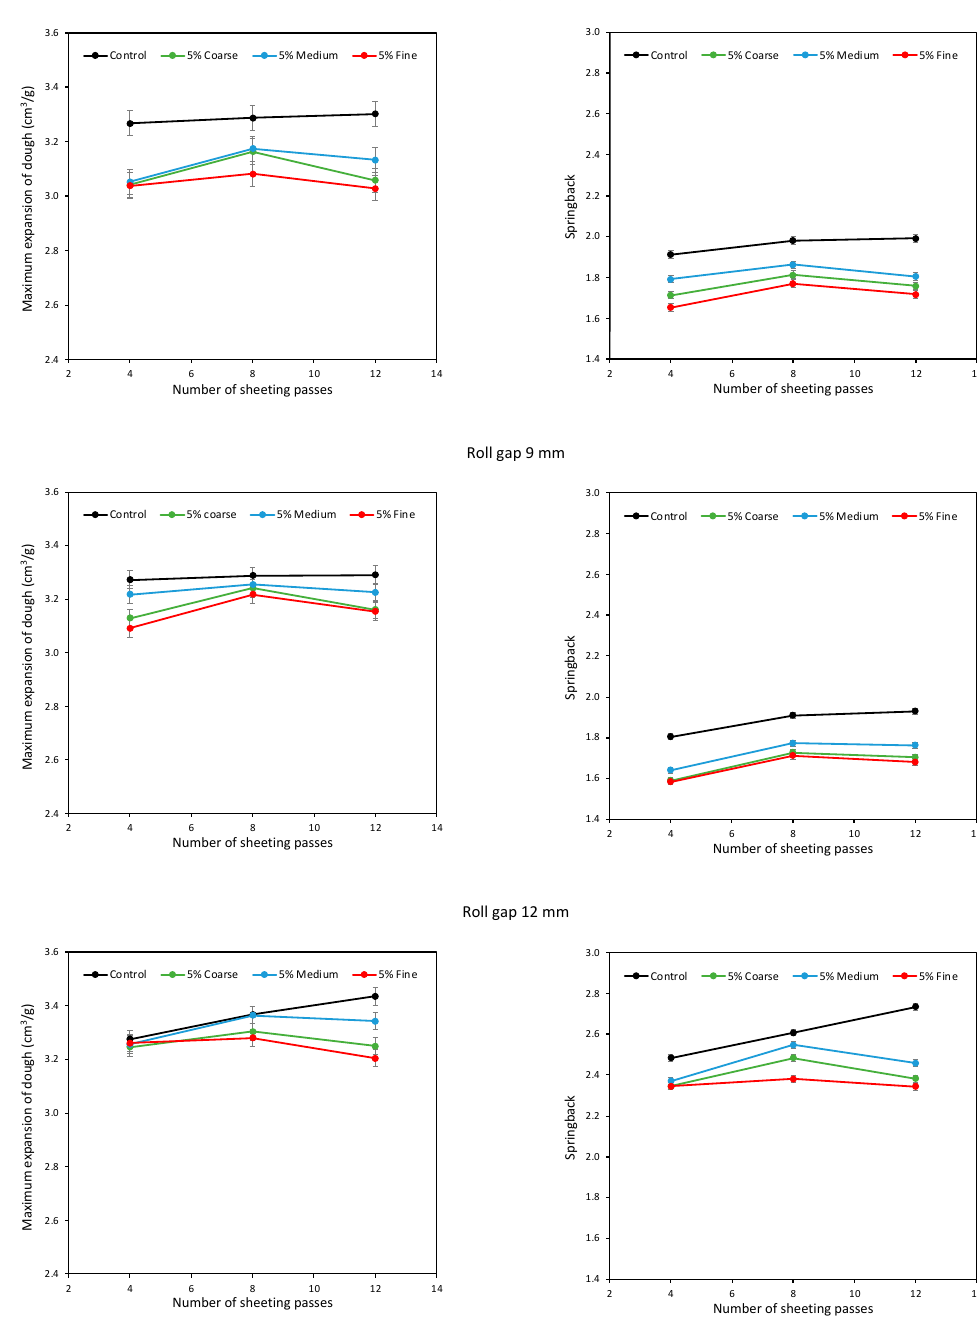
Figure 4. Average expansion ( left ) and springback ( right ) of doughs containing 5% Fine, Medium and Coarse bran, sheeted at roll gaps of 6 ( top ), 9 ( middle ) and 12 mm ( bottom ).